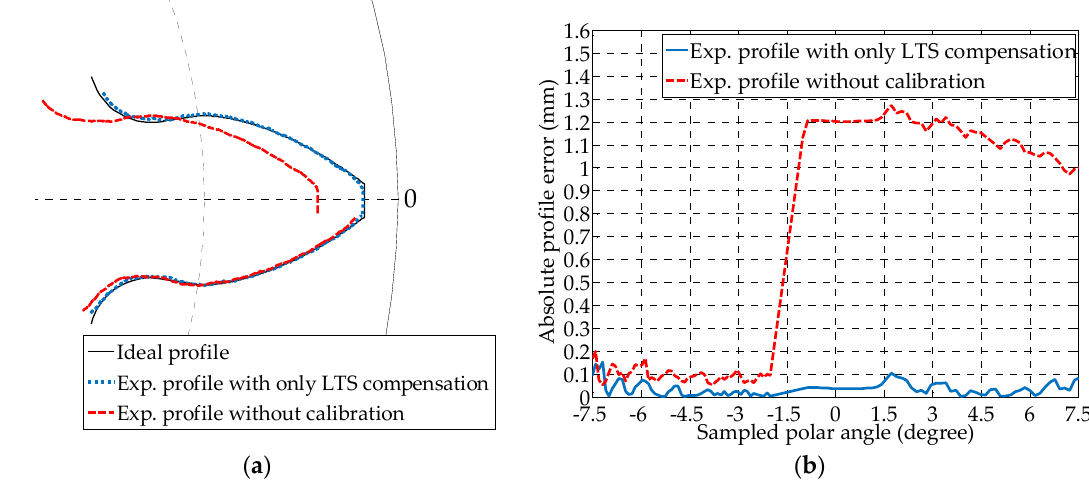
Figure 8. Error comparison between the calibrated gear profile result at x 1 = 0 mm, with yaw and pitch angle compensated from installation error, and the uncalibrated result without spatial error compensation: ( a ) Comparison of reconstructed tooth profiles; and ( b ) Comparison of profile error with respect to the ideal profile.